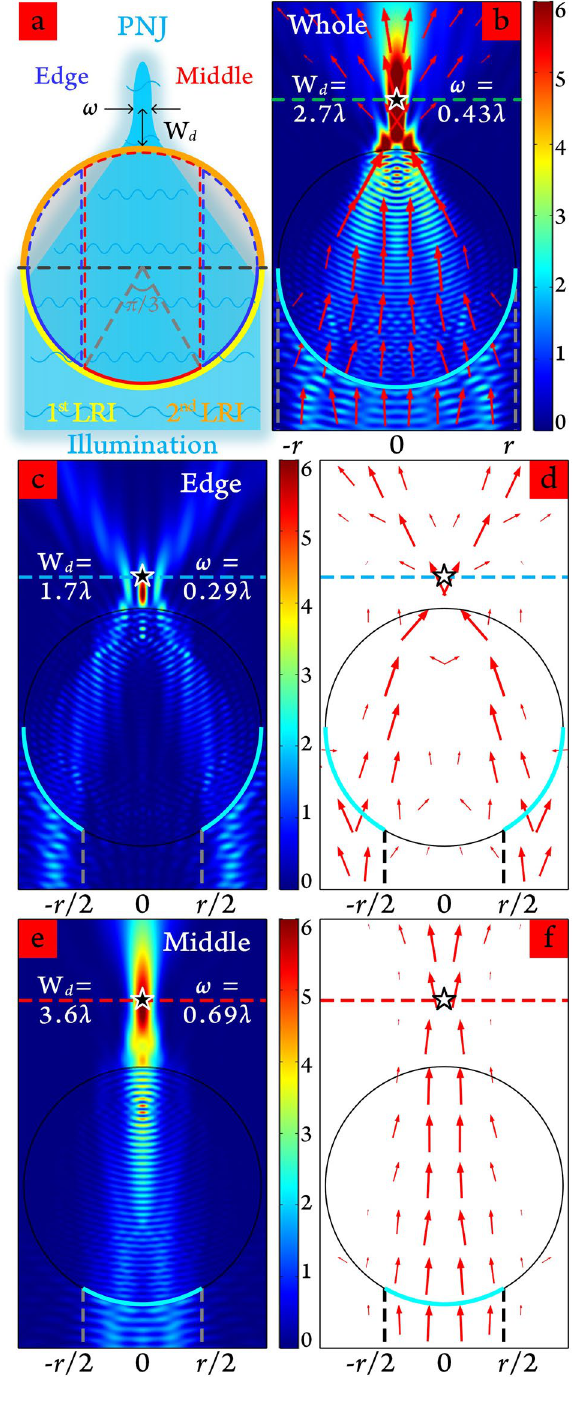
Figure 1. ( a ) Structural components of cylindrical microparticles for generating PNJ under light illumination, including the 1 st (yellow semi-circular arc) and the 2 nd (orange semi-circular arc) LRIs. Three regions with the same arc lengths of the 1 st LRI: one middle region (red arc) and two edge regions (blue arcs). W d is the distance from the surface of the microparticle to the position of maximum light intensity, ω is the minimum FWHM beam width. ( b ) Electric field intensity of plane wave illuminating the whole boundary of the 1 st LRI. Wavelength λ = 400 nm, microparticle radius r = 2.5 μ m and the arrows denote the distribution of Poynting vector field. ( c ) Edge regions and ( e ) middle region are illuminated in the vertical direction, forming PNJs. ( d , f ) the corresponding Poynting vector distributions of the irradiation areas located at the edge and middle regions, respectively. The five-pointed stars in ( b )–( f ) mark the positions of maximum light intensity. The Ri of the microparticle is